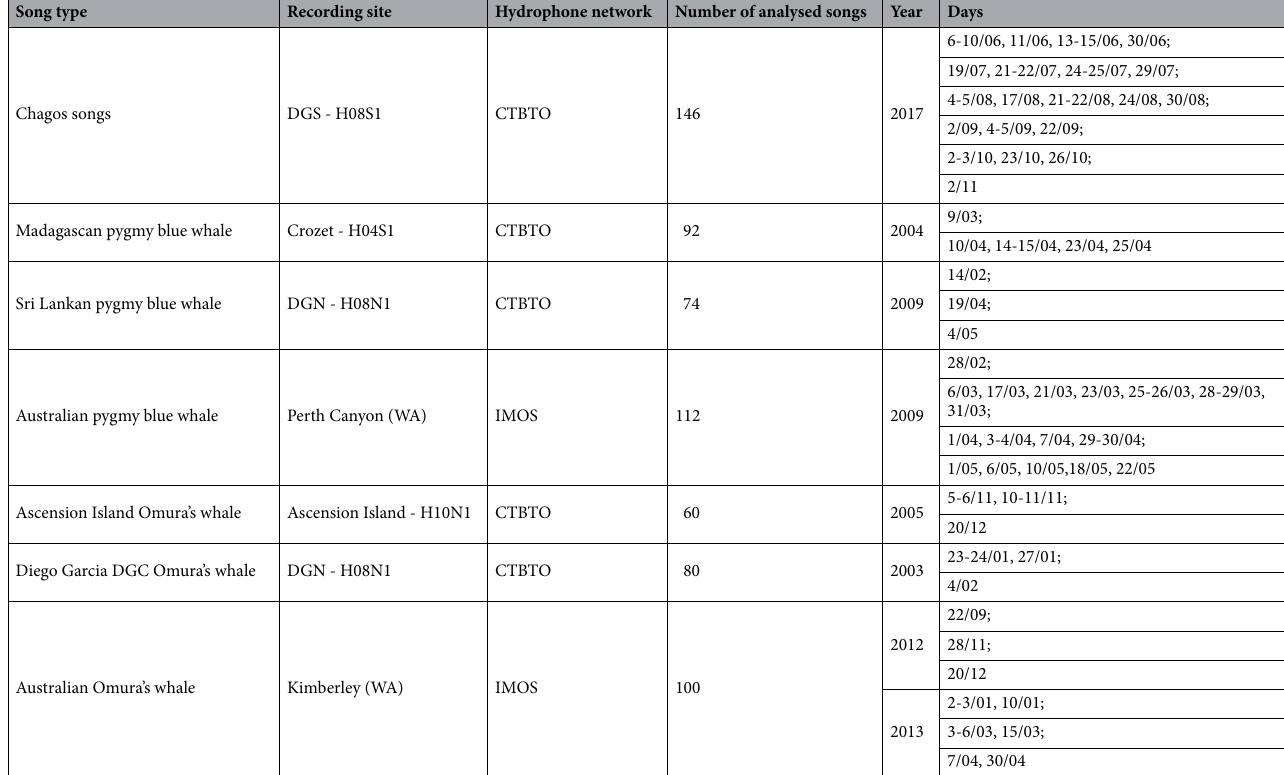
Table 3. Recording sites and dates, and number of analysed Chagos, pygmy blue and Omura’s whale song-